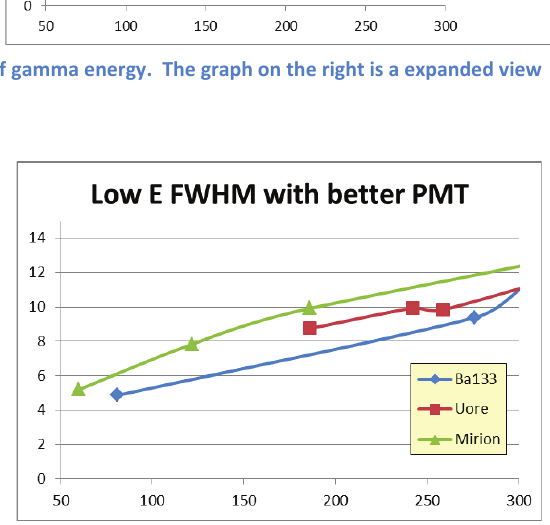
Figure 11 FWHM for low energy nuclides when measured with higher performance